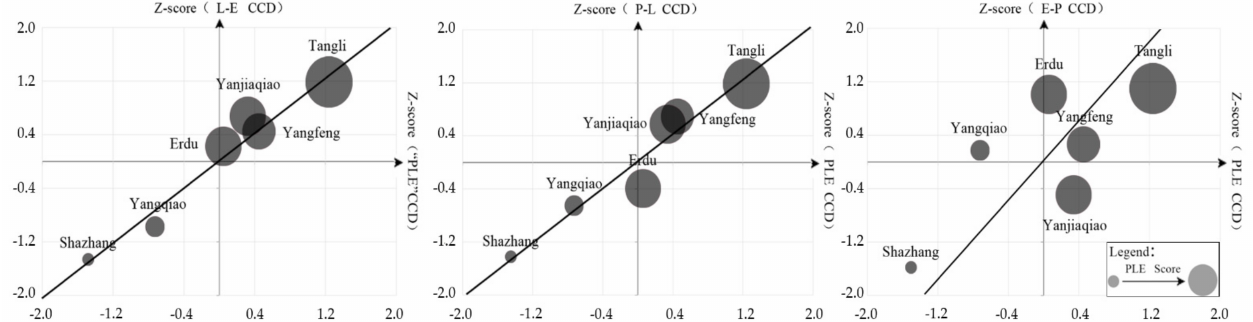
Figure 7. The relationship of PLE CCD with pairwise mutual CCDs.